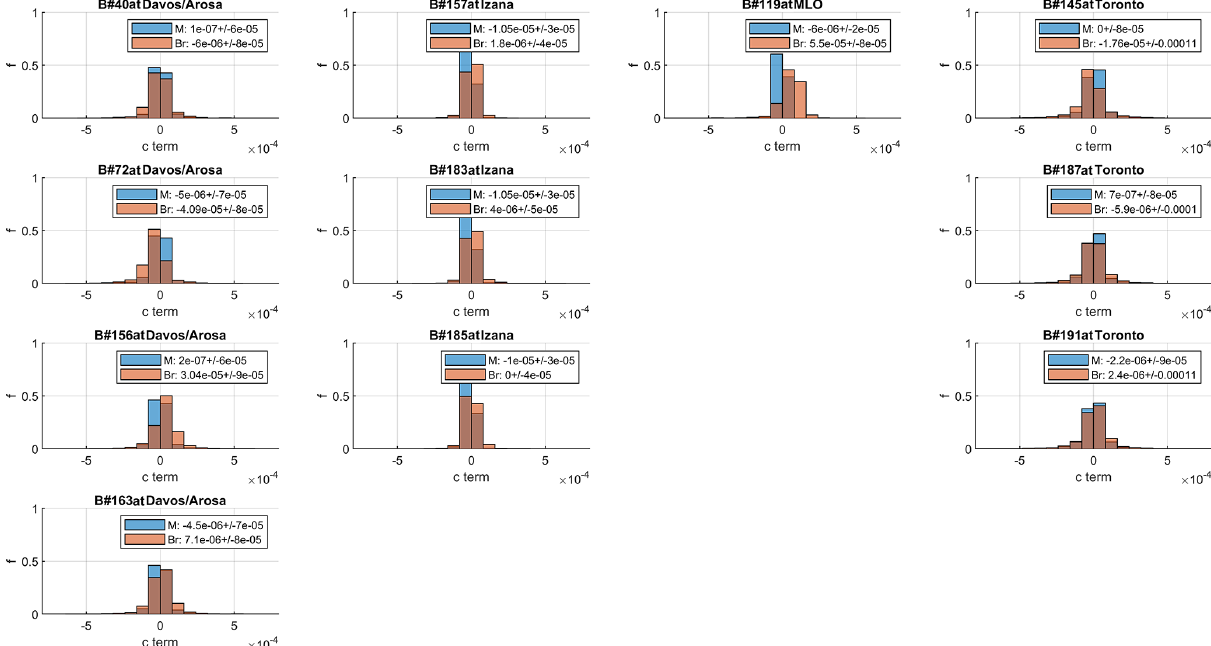
Figure A6. Histograms of second-order polynomial fitting coefficient (second-order term; quadratic term) for daily ozone. The values indi- cated in the legends are the mean ± 1 σ of the